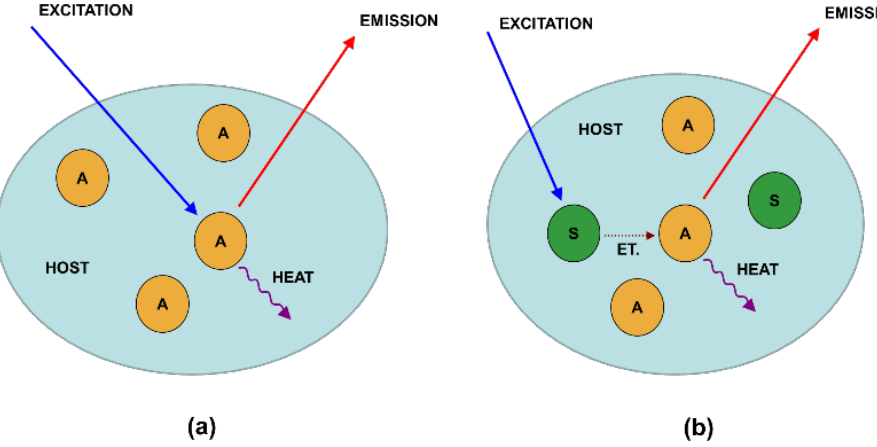
Figure 1. ( a ) Only activators participate in the luminescence process. (A is the activator and S is the sensitizer.) ( b ) The luminescence process has the simultaneous action of activator and sensitizer. Reprinted with permission from [1] © 2013 Royal Society of Chemistry.